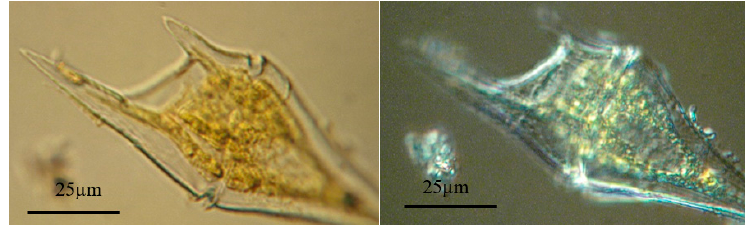
Figure 2. Microscopic images of a specimen of Tripos furca . Left, normal vision; right, Nomarski di ff erential contrast.